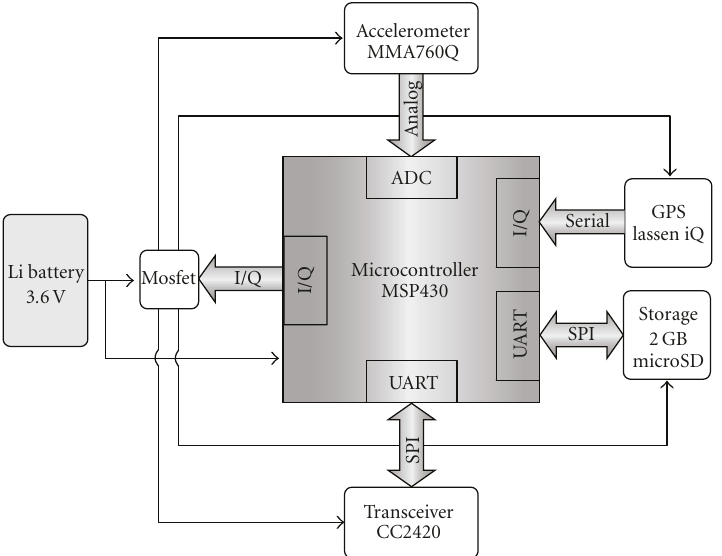
Figure 2: Top level block diagram of the CARNIVORE hardware. Black arrows indicate power connections. Thick shaded arrows indicate control and data connections.